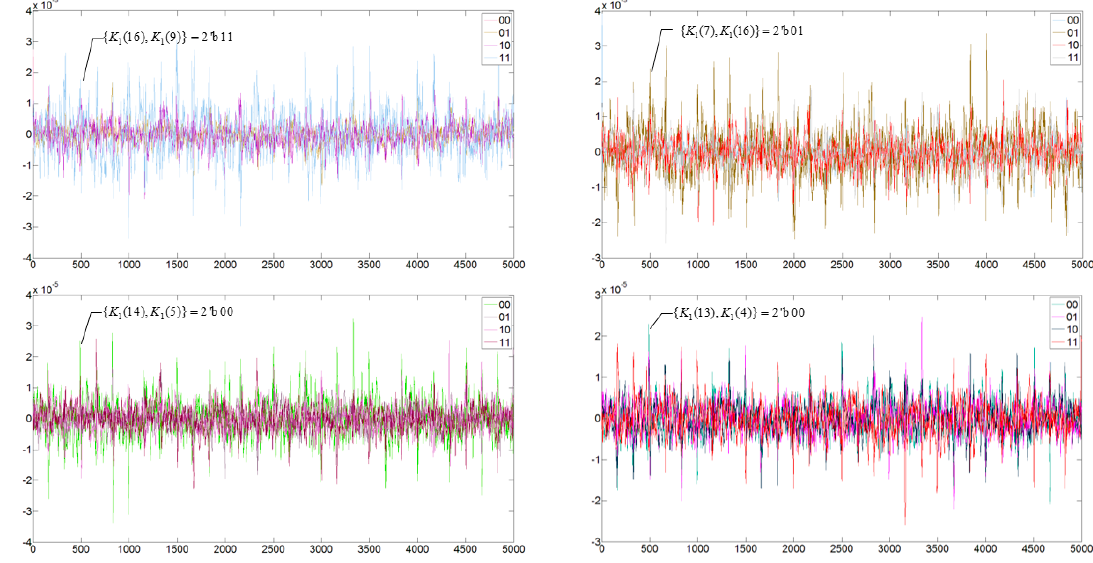
Figure 6. The results of the DPA attack of { K 1 (16), K 1 (14), K 1 (13), K 1 (9), K 1 (7), K 1 (5), K 1 (4)}.